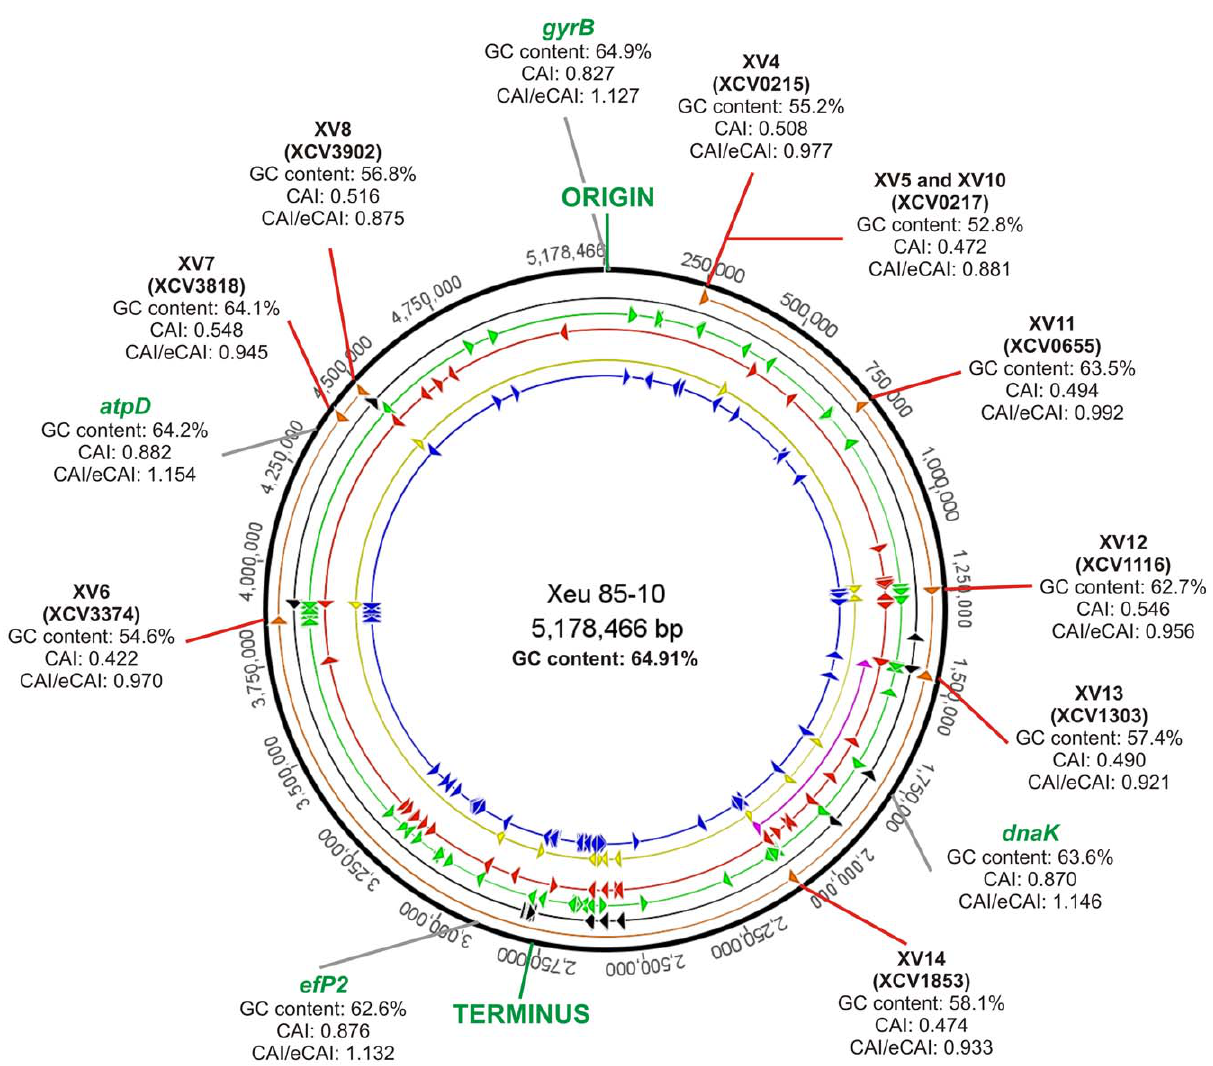
Figure 1. Genome map of X.euvesicatoria str. 85-10. Circles, from the outside in, show: genome coordinates (bp), selected DNA markers (orange), phage related ORFs (black), IS elements (green), tRNAs (red), recombinases (purple), integrases (yellow) and transposases (blue). The GC content, Codon Adaptation Index (CAI) and normalized CAI (CAI/eCAI) values are shown for each marker and for four housekeeping genes.